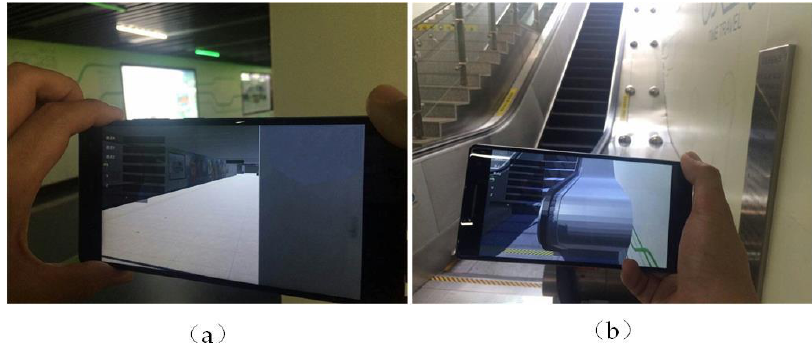
Figure 4. Camera tracking in a virtual subway station ( a ) at the corner, ( b ) near the elevator.